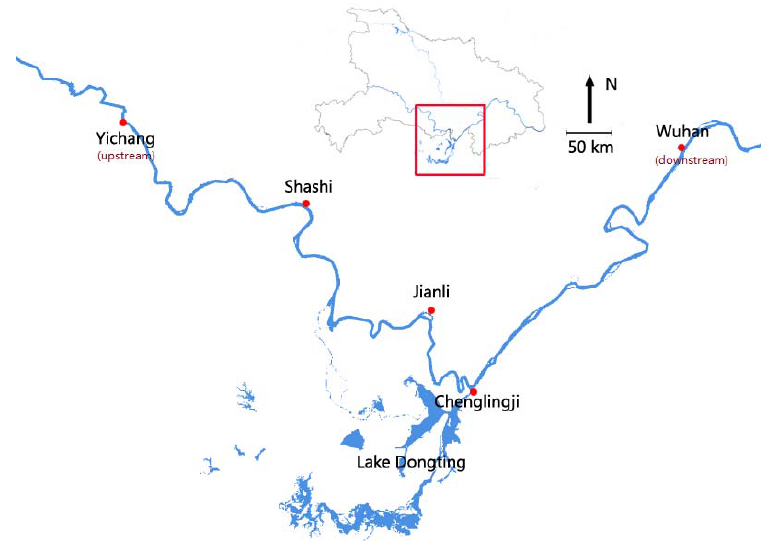
Figure 1. Research domain and locations of water level stations.